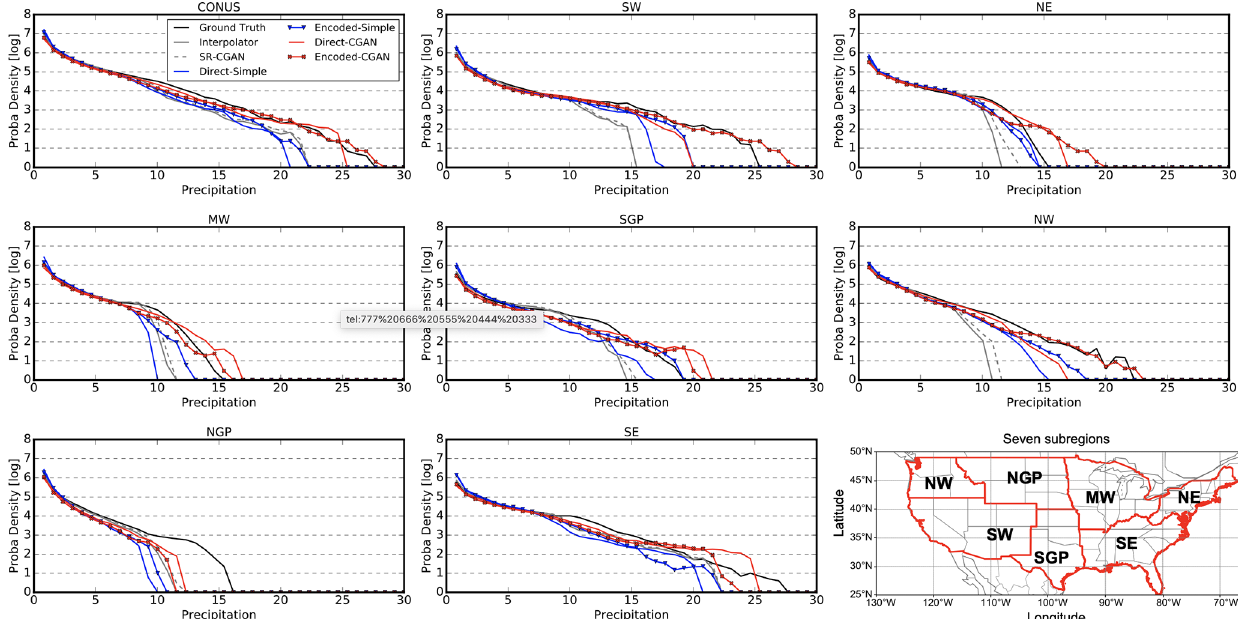
Figure 6. PDFs from Ground Truth, Interpolator, and CNN-predicted precipitation calculated based on grid cells and time steps over CONUS and seven subregions. The subregions are based on those used in the national climate assessment: Northeast (NE), Southeast (SE), Midwest (MW), Southwest (SW), Northwest (NW), Northern Great Plains (NGP), and Southern Great Plains